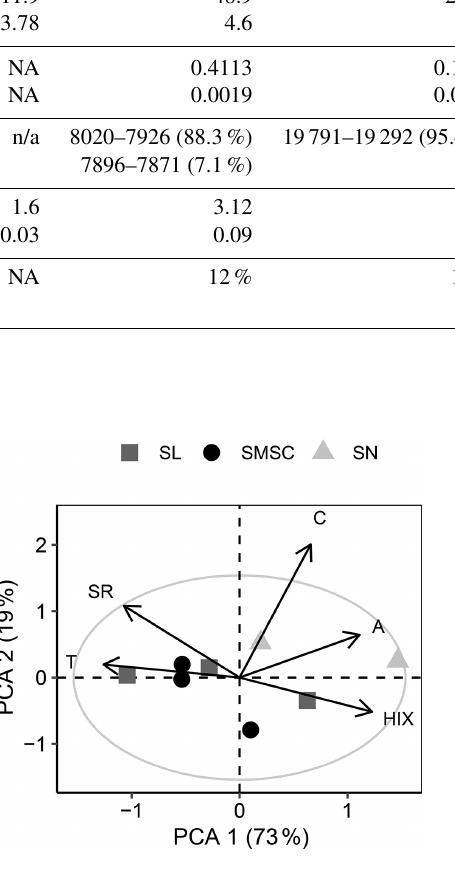
Figure B1. Principal component analysis of optical indices for BEPOM of different size fractions. PCA is shown in scaling 1. The grey circle marks the circle of equilibrium contribution. Abbreviations of optical indices are as in Table S5; SN = 63–2000 µm, SL = 20–63µm, SMSC = <